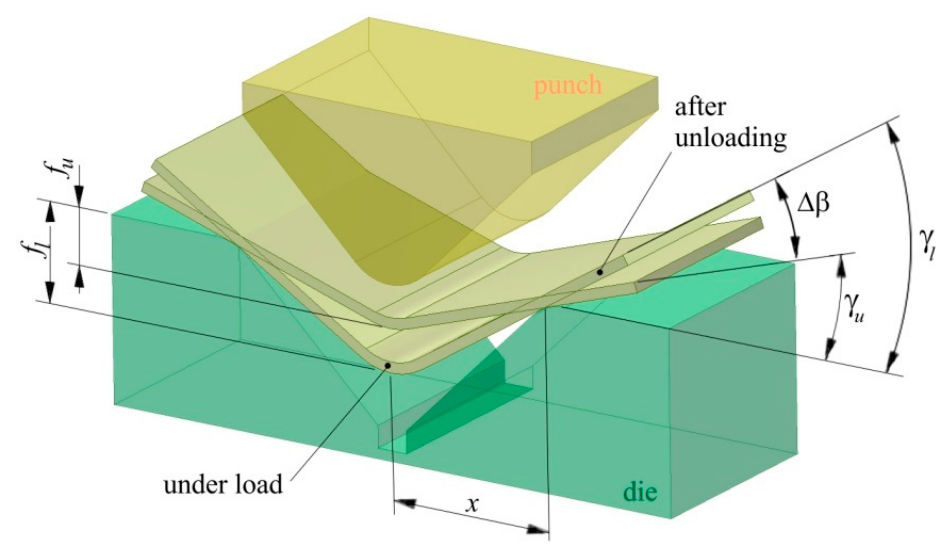
Figure 2. A schematic diagram of the measurement of springback.